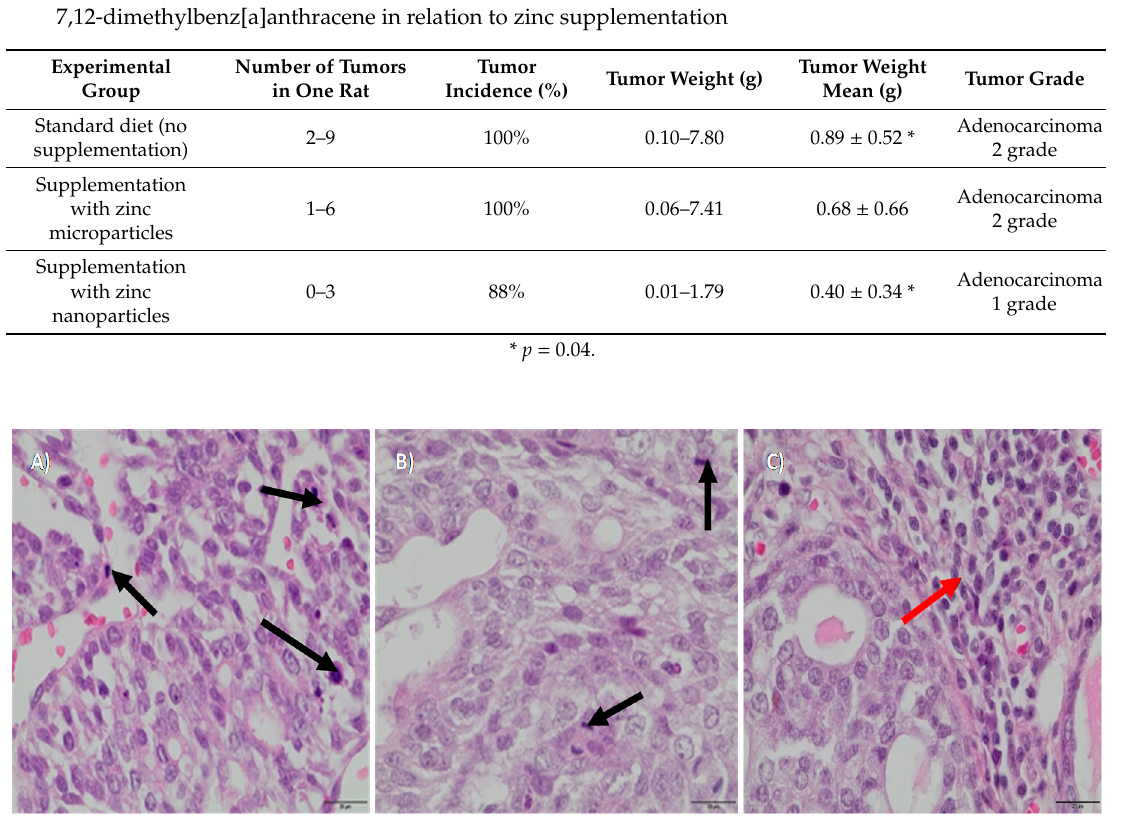
Figure 2. Biopsy images of tumor samples with 40x magnification; hematoxylin and eosin staining was applied. DMBA (7,12-dimethylbenz[a]anthracene) -induced tumor in the control group—II grade adenocarcinoma ( A ), in the group with the zinc microparticles supplementation—II grade adenocarcinoma ( B ), in the group supplemented with zinc nanoparticles—I grade adenocarcinoma ( C ). Black arrows indicate areas of increased proliferation ( A , B ). Red arrow indicates inflammatory infiltrates ( C